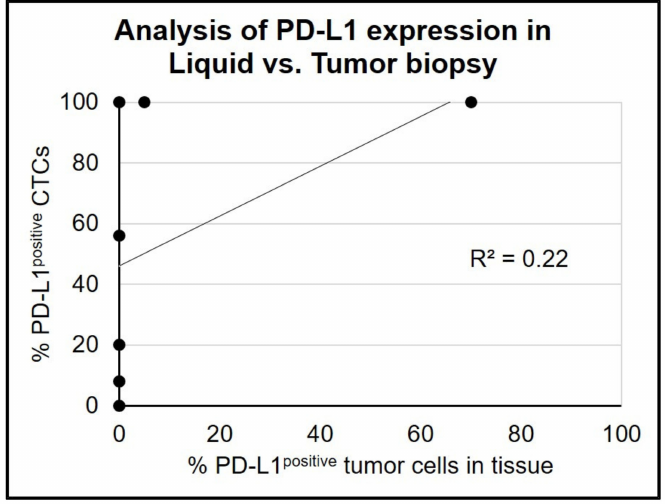
Figure 5. Paired analysis of PD – L1 expression in tumor tissue and liquid biopsy. Cases with ≥ 3 CTCs detected at baseline were used for paired analysis of PD–L1 expression analysis in tumor tissue and corresponding liquid biopsy. (pairs n = 7; BC: n = 2, HNSCC: n =